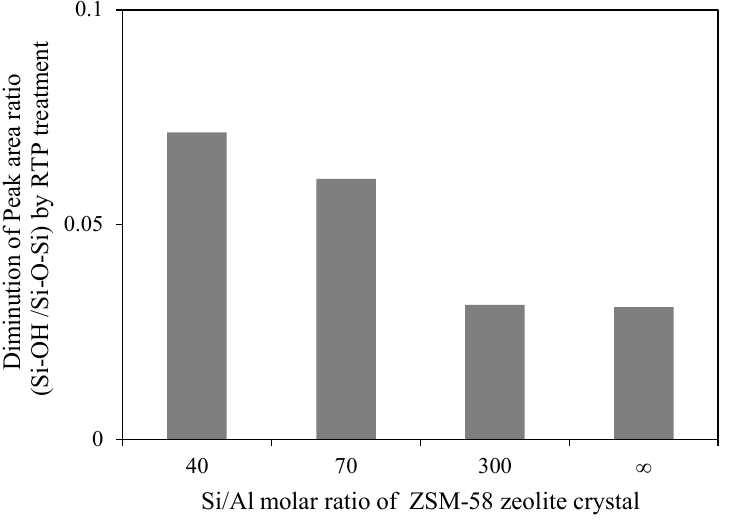
Figure 13. Diminution of peak area ratio (Si–O–H/Si–O–Si) on ZSM-58 crystals with different Si/Al molar ratios after RTP treatment.